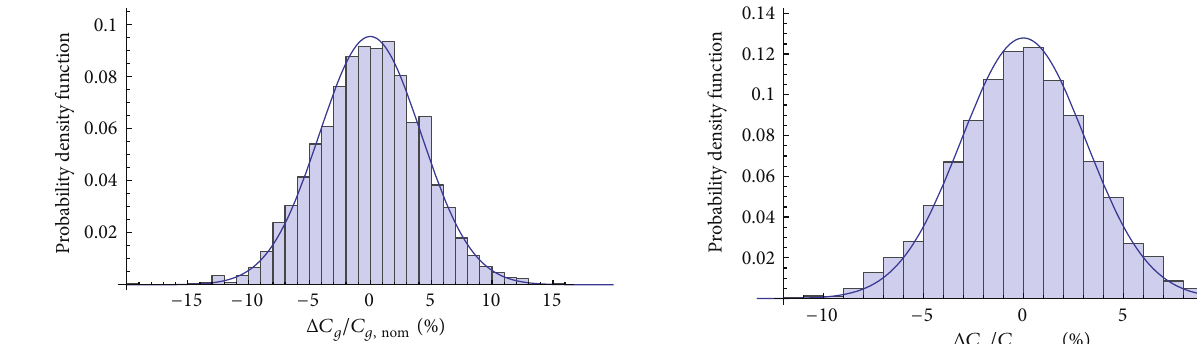
(𝛿𝐶 ) (line) versus benchmark distribu- 𝑔 𝑔